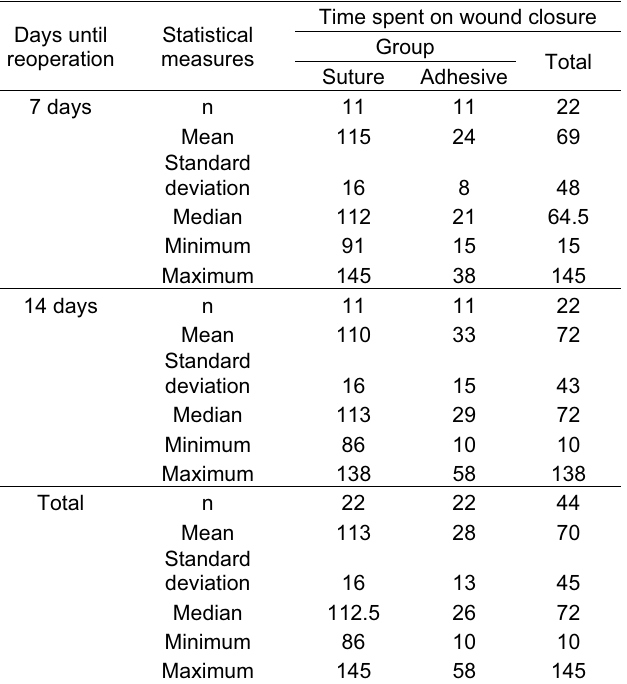
TABLE 4 – Time spent on wound closure (in seconds)